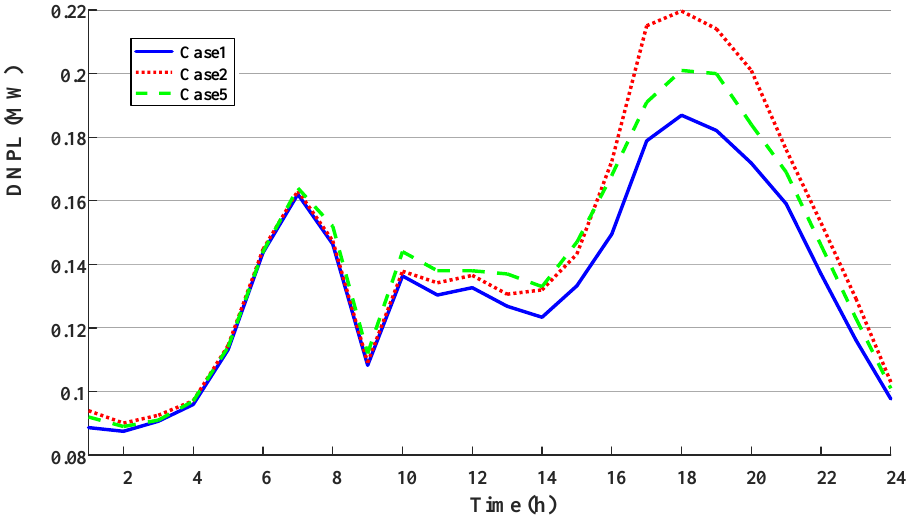
Figure 7. Daily power loss of the distribution network.